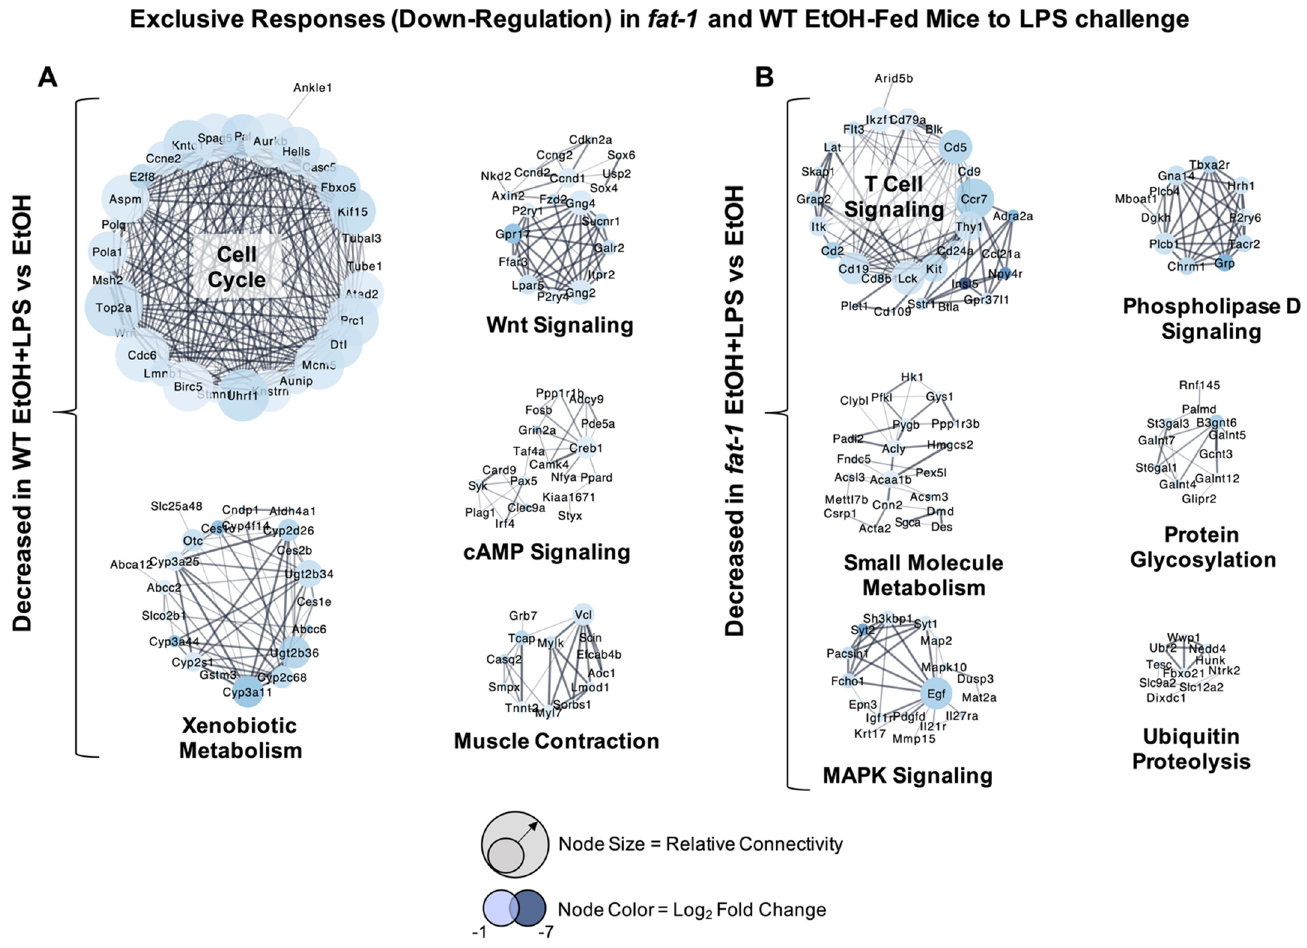
Figure 4. Exclusive transcriptional responses decreased due to EtOH + LPS in WT and fat-1 mice. ( A ) Cluster analysis of ileum genes decreased exclusively in WT mice in response to EtOH + LPS vs. EtOH. ( B ) Cluster analysis of ileum genes decreased exclusively in fat-1 mice in response to EtOH + LPS vs. EtOH. Node size indicates relative connectivity. Node color indicates relative log 2 (Fold-Change) of genes.